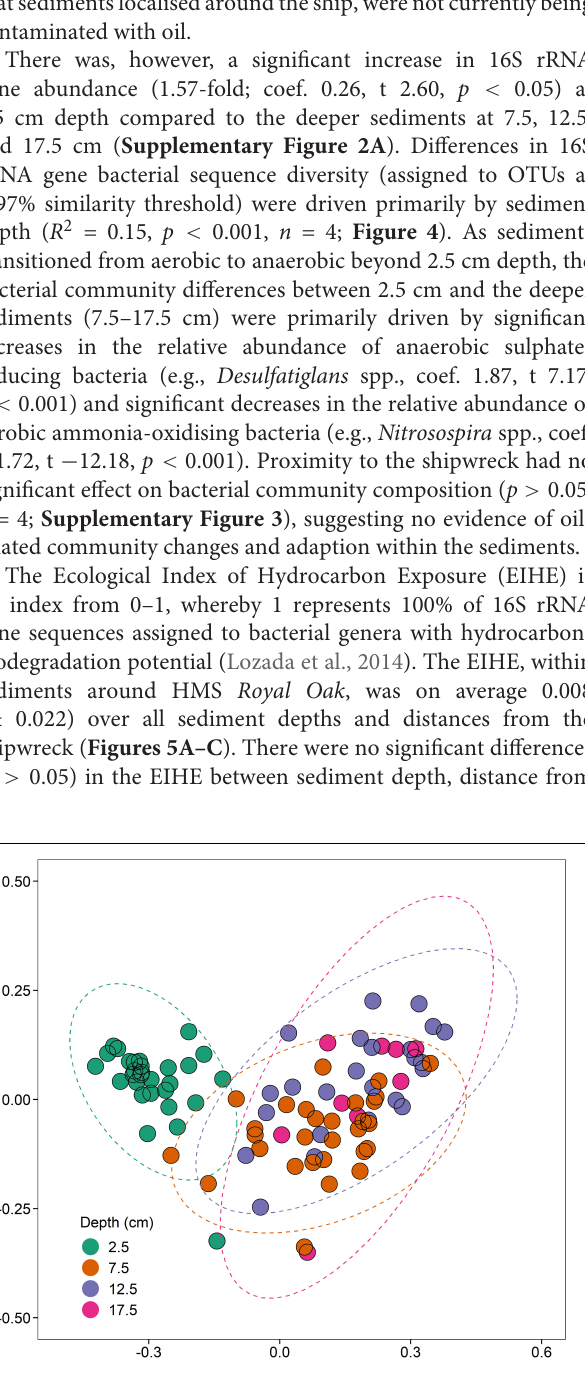
FIGURE 4 | NMDS (non-metric multidimensional scaling) ordination (stress = 0.10), based on clustered bacterial 16S rRNA OTUs at a 97% similarity threshold, displaying the effect of depth (cm) on bacterial community composition ( R 2 = 0.15, p < 0.001, n =